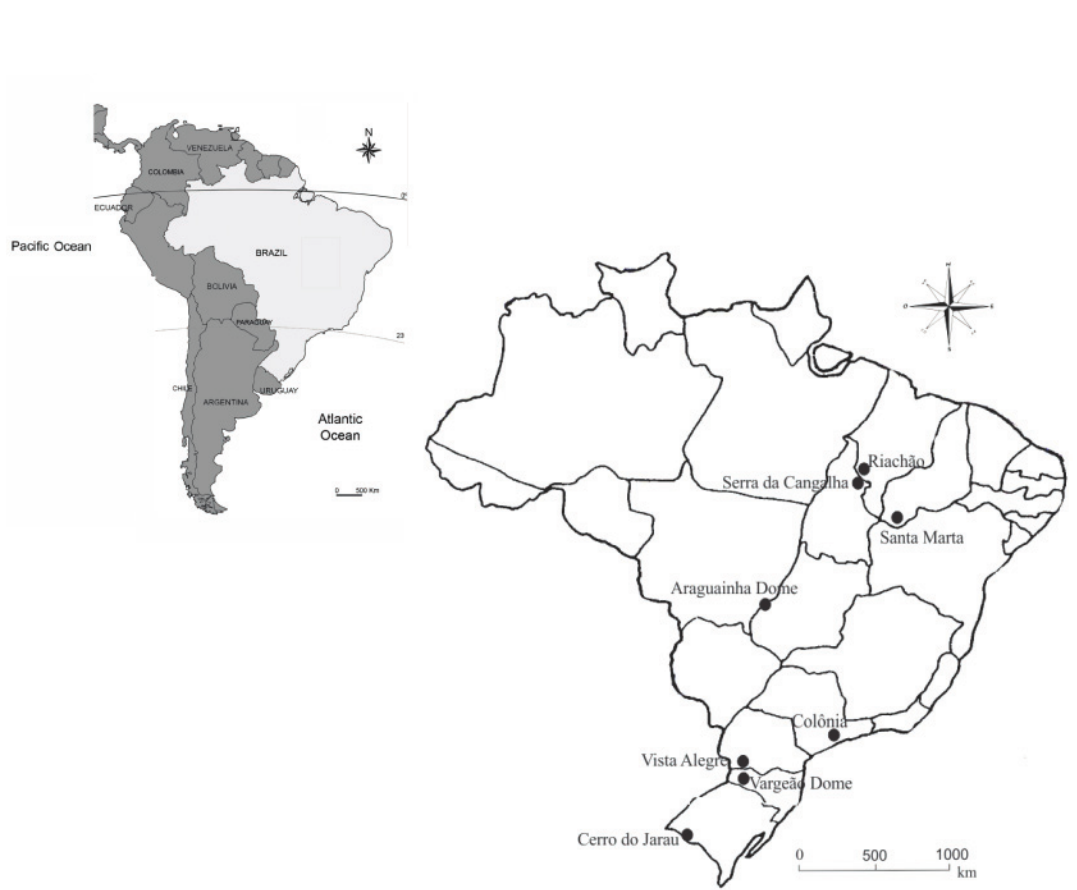
Figure 1 - General location of confi rmed impact structures in